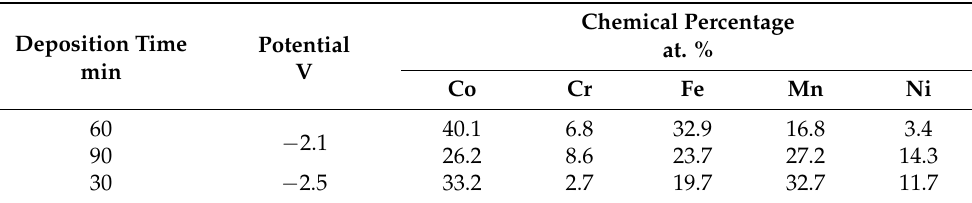
Table 2. HEA thin films chemical composition for electrodeposition at different potentials for 30, 60, and 90 min.